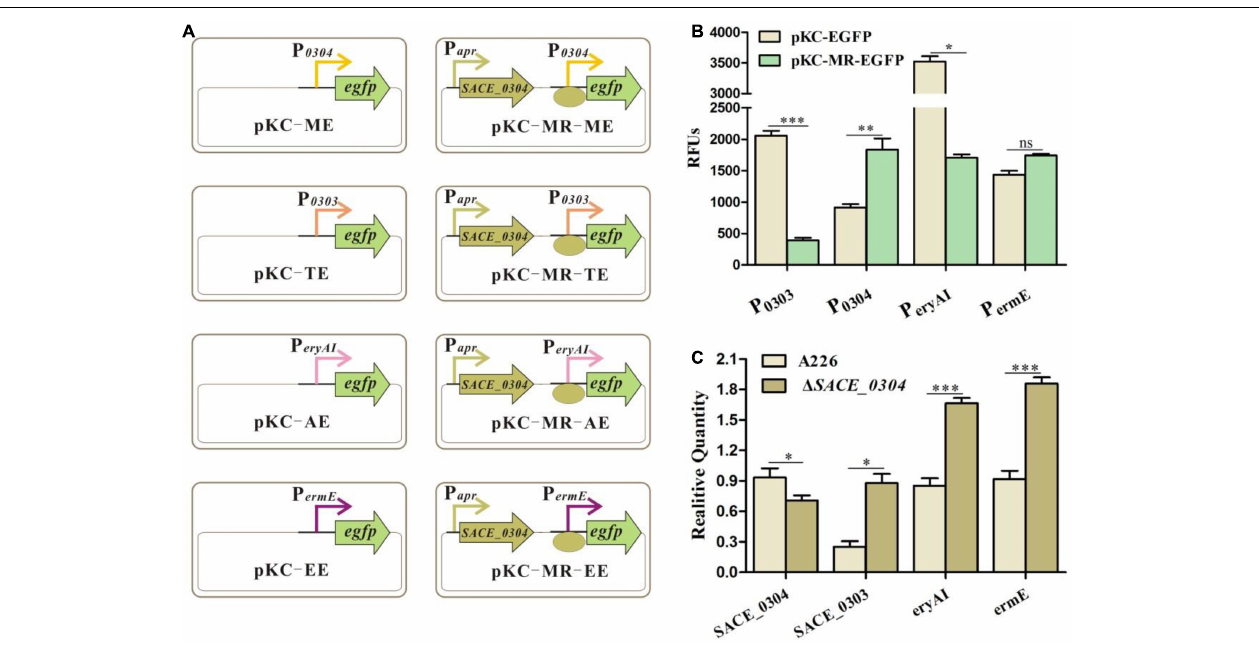
FIGURE 4 | Regulatory mode of SACE_0304. (A) An illustration of the reporter plasmids. (B) Detection of the relative fluorescence units (RFUs) after different promoters in E. coli DH5 α /pKC-EGFP and DH5 α /pKC-MR-EGFP. (C) Effects of SACE_0304 disruption on transcripts of SACE_0303 , SACE_0304 , eryAI , and ermE . Error bars (B,C) : SD from triplicate experiments. Statistical notations (B,C) : ns, not significant. ∗ p < 0.05, ∗∗ p < 0.01, ∗∗∗ p <